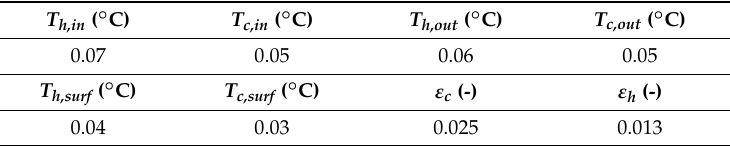
Table 3. Overall uncertainty of measured